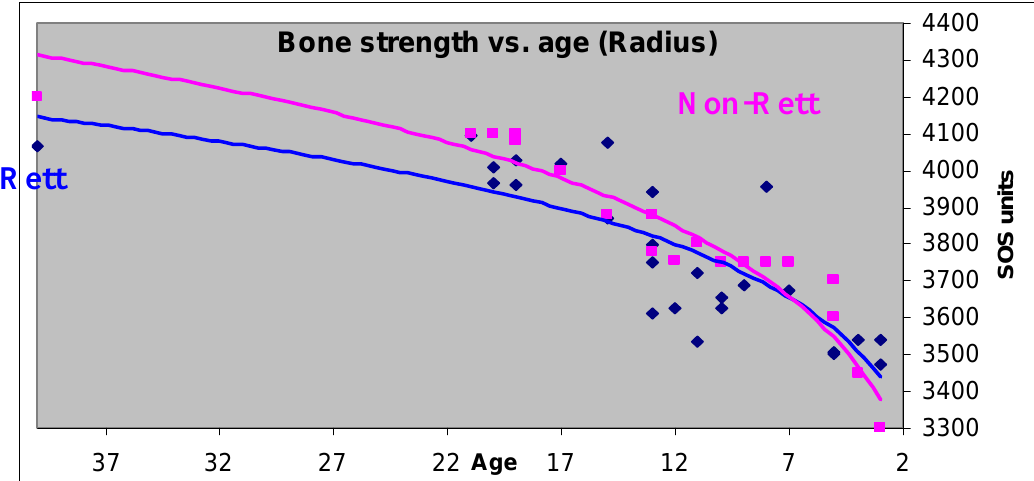
FIGURE 1 . A comparison of bone strength values for Rett and non-Rett